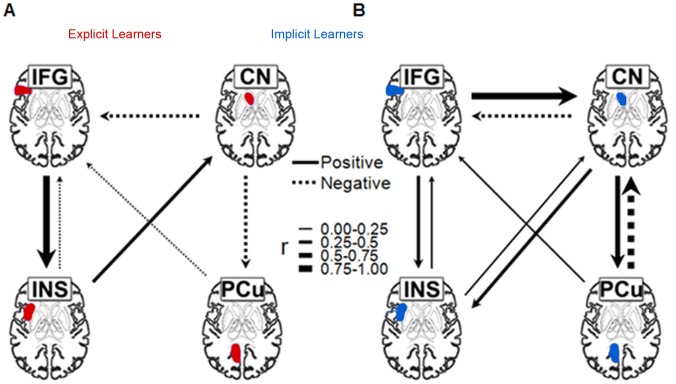
Brain networks for explicit and implicit learners during grammaticality judgment.Positive relationship were denoted by solid lines and negative relationships by dotted lines. See text for further explanation.